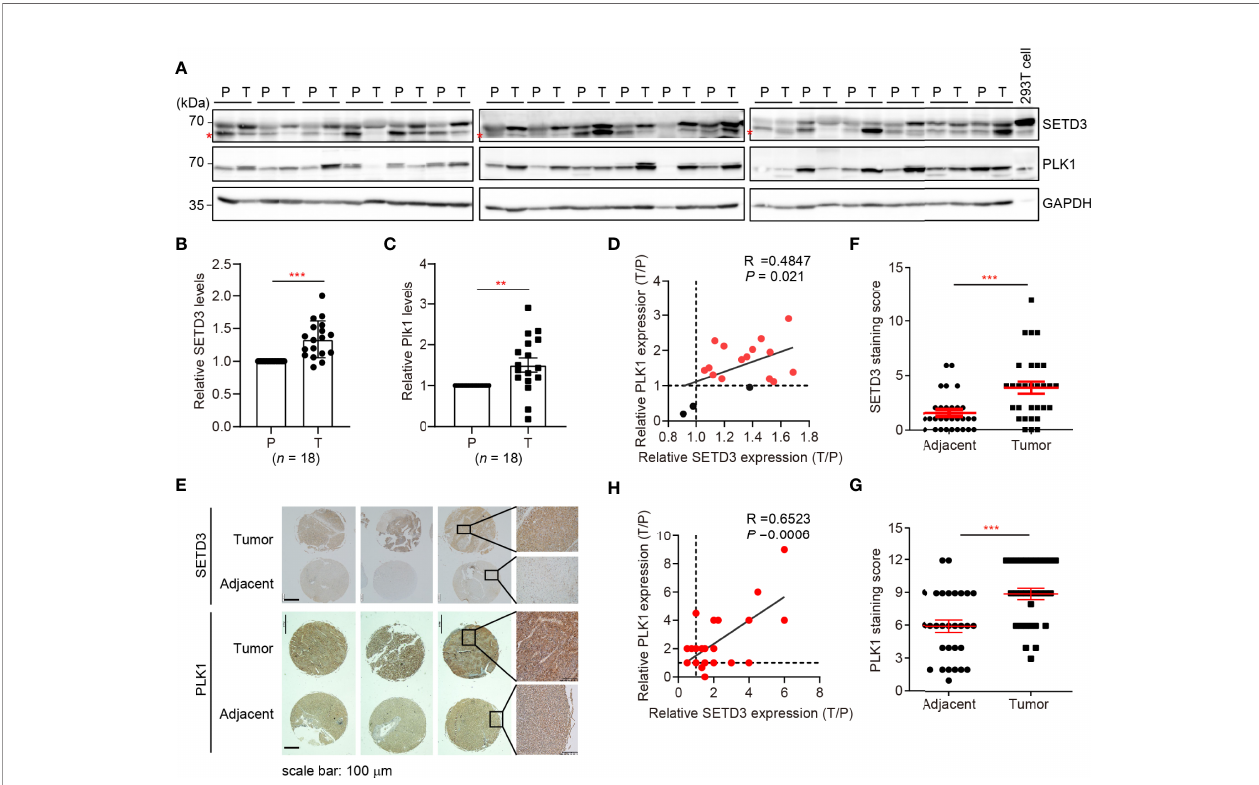
FIGURE 4 | SETD3 levels are positively correlated with PLK1 expression in liver tumors. (A – C) Eighteen pairs of human liver samples including adjacent tissues (P) and tumor tissues (T) were examined using Western blotting (A) . Relative protein levels of SETD3 (B) or PLK1 (C) in the tumor tissues compared with the corresponding adjacent tissues were quanti fi ed. (D) The correlation of SETD3 and PLK1 levels from Western blots in panels (B, C) were plotted (R =0.4847, p =0.021). The dots represent the relative levels from each tumor sample overlapped as one dot in the graphs. (E – G) IHC staining of SETD3 and PLK1 in human liver cancer and adjacent tissues obtained from tissue microarrays (24 pairs). Representative IHC staining images of SETD3 and PLK1 from the same arrays are shown in panel (E) . Scale bar, 100 m m. Scores of the staining of SETD3 or PLK1 in panel (E) are plotted as in panel (F) or (G) , respectively. n =24. (H) The correlation of SETD3 and PLK1 levels from IHC staining in panel (E) were plotted (R =0.6523, p =0.0006). Data are presented as mean ± SD. ** p < 0.01; *** p <